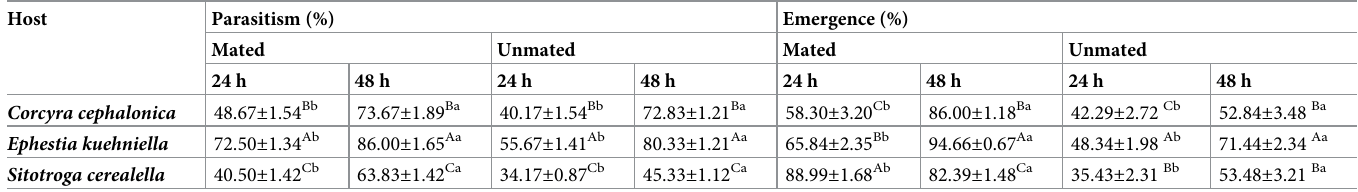
Table 1. Parasitism and emergence of Trichogramma japonicum on different factitious host eggs, when host eggs were exposed to mated and unmated female para- sitoids for 24 and 48 h. Host Parasitism (%) Emergence (%) Mated Unmated Mated Unmated 24 h 48 h 24 h 48 h 48 h Corcyra cephalonica 48.67 ± 1.54 Bb Ephestia kuehniella 72.50 ± 1.34 Ab Sitotroga cerealella Capital letters within columns, lowercase letters within rows with the same letter after the Means ± SE did not differ significantly as per one-way ANOVA and Student’s t - test ( P < 0.01),